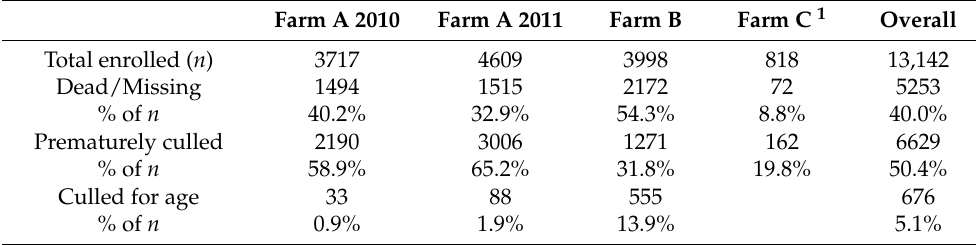
Table 1. Number and percentage (%) of ewes that were enrolled in this study and subsequently classified as dead/missing, prematurely culled or culled for age, following exit of all ewes from each cohort, for each enrolled cohort, and as an overall across cohorts. n represents total enrolled ewes for each cohort, and overall across cohorts.